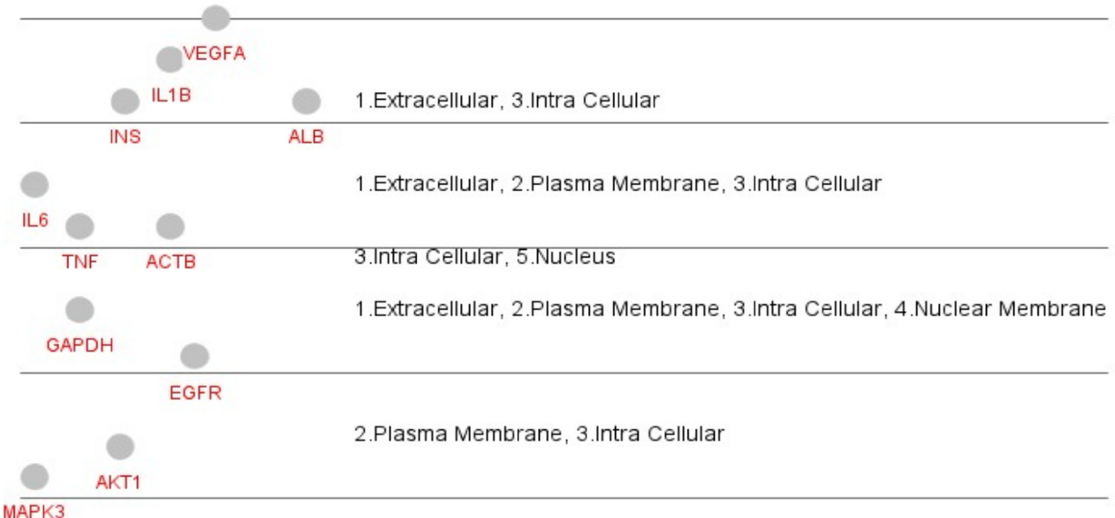
Figure 5. The pie chart result of GO term analysis with interaction pathway obtained using ClueGo.